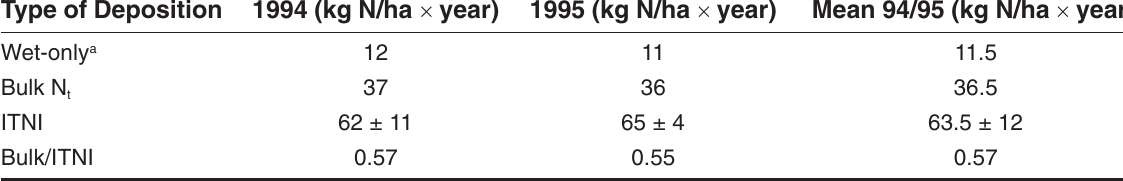
Summarized Results of Different N Deposition Measurements from 1994/95 at Bad Lauchstädt Type of